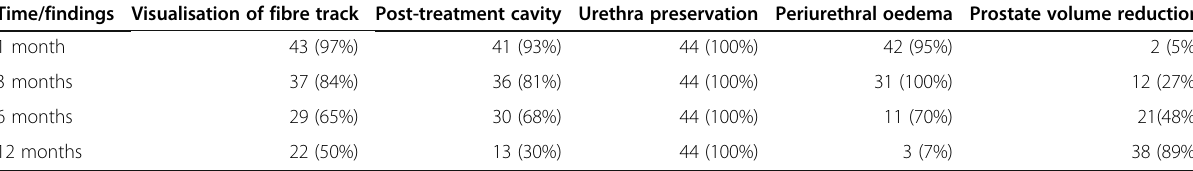
Table 4 Magnetic resonance imaging findings at 1, 3, 6, and 12 months after the procedure (patients, n =